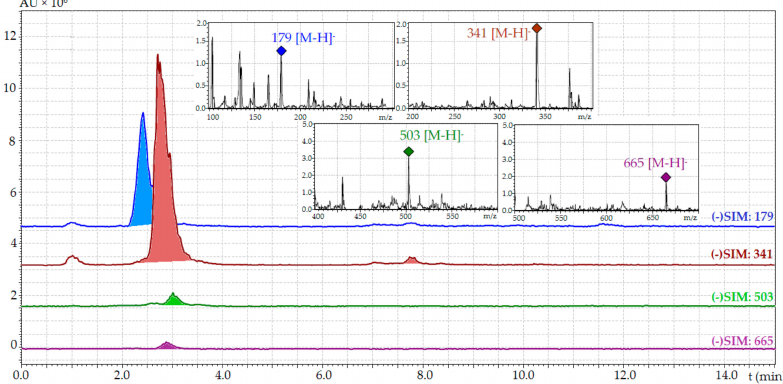
Figure 3. RP-HPLC-MS chromatograms in selected ion monitoring mode (SIM, negative ionization) of free sugars fraction of D. palmatum herb (low-temperature sample). SIM with following m / z value used: 179 for glucose, 341 for sucrose, 503 for raffinose, 665 for stachyose. On cuts, mass spectra of corresponding compounds; AU, absorbance